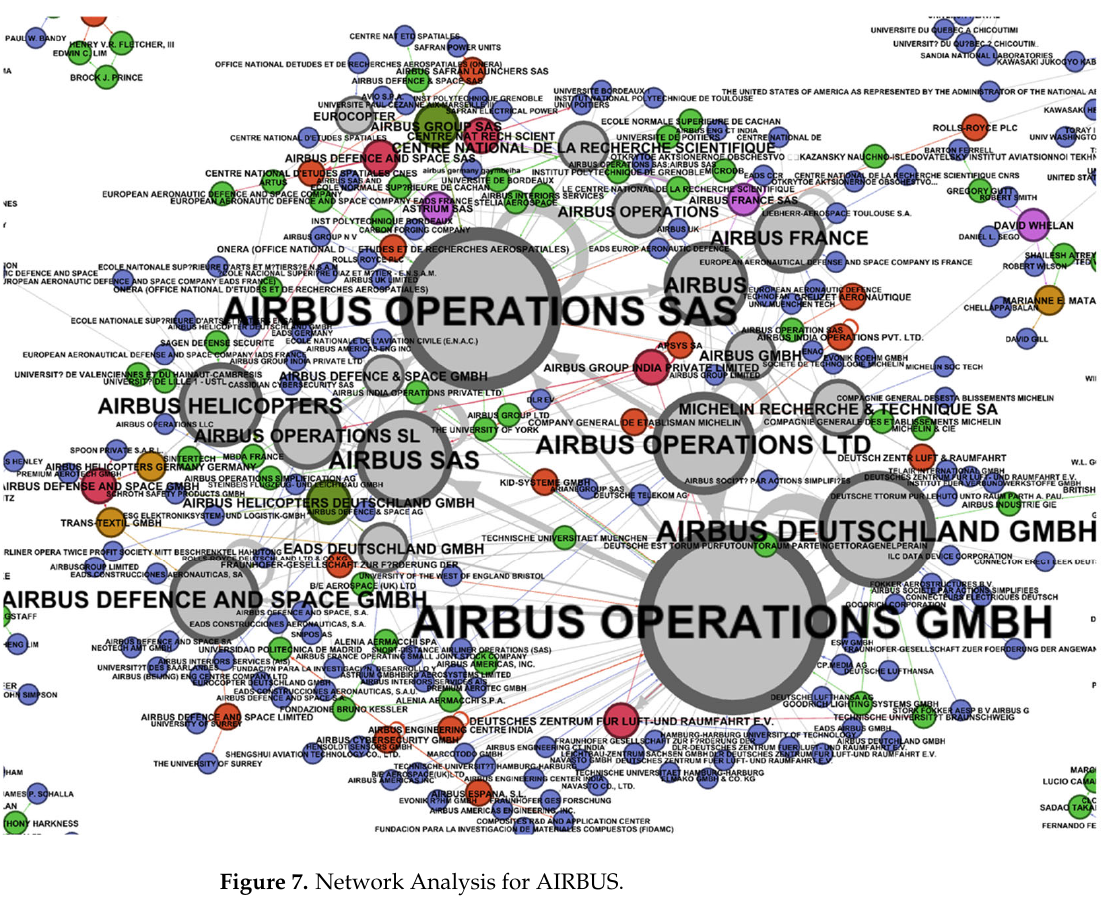
Figure 7. Network Analysis for AIRBUS.